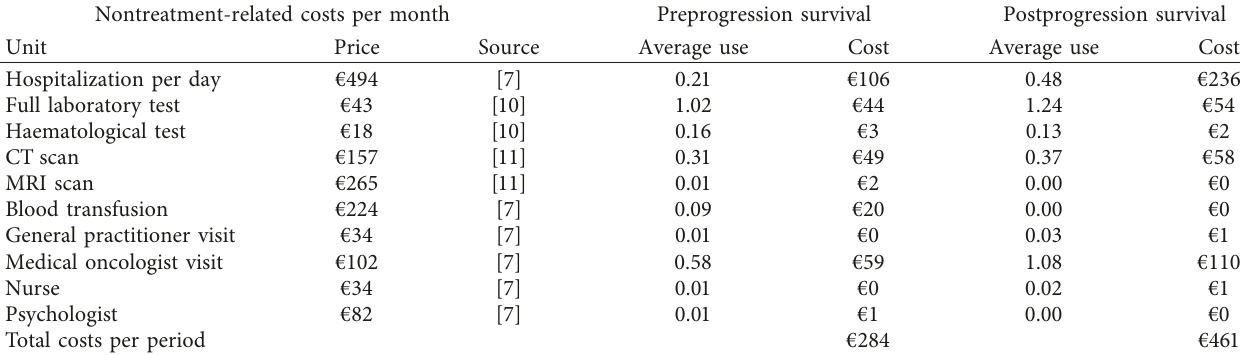
Table 4: Nontreatment-related costs per month during preprogression survival and postprogression